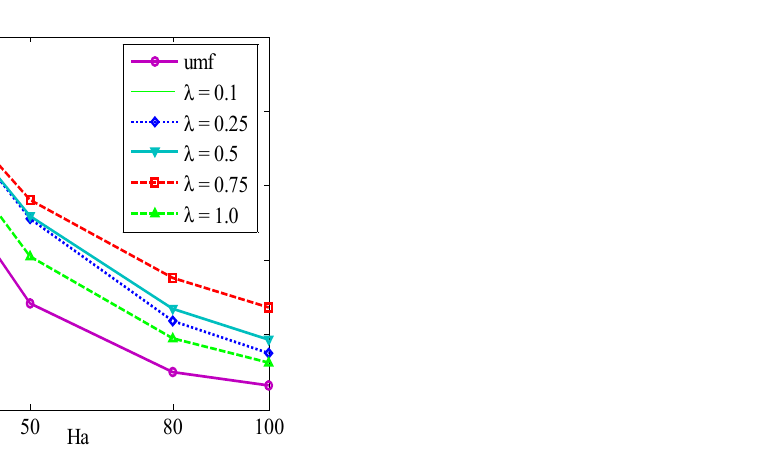
Figure 11. Average Nusselt number ( Nu av ) with Hartmann number for uniform magnetic field and different periods of the magnetic field when Ra = 10 6 , Ha = 30, d = 10 nm, n = 3, ϕ = 0.04, and τ = 1.